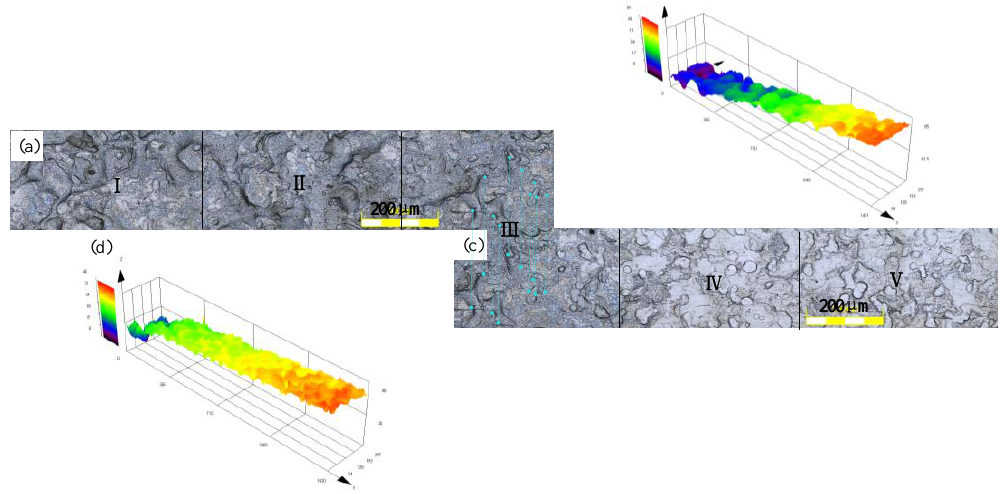
Figure 5. Surface topography of contact arc zone. ( a , c ) The 2D LSCM scan images. ( b , d ) The 3D LSCM scan images.